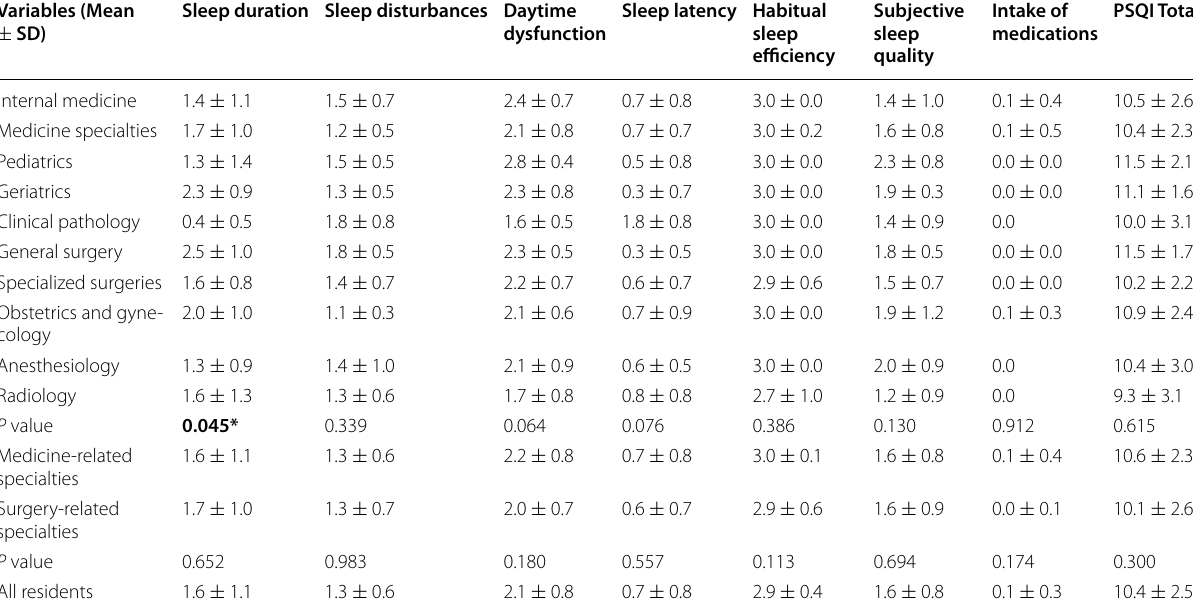
Table 3 Pittsburgh Sleep Quality Index (PSQI) among different resident’s specialty Variables